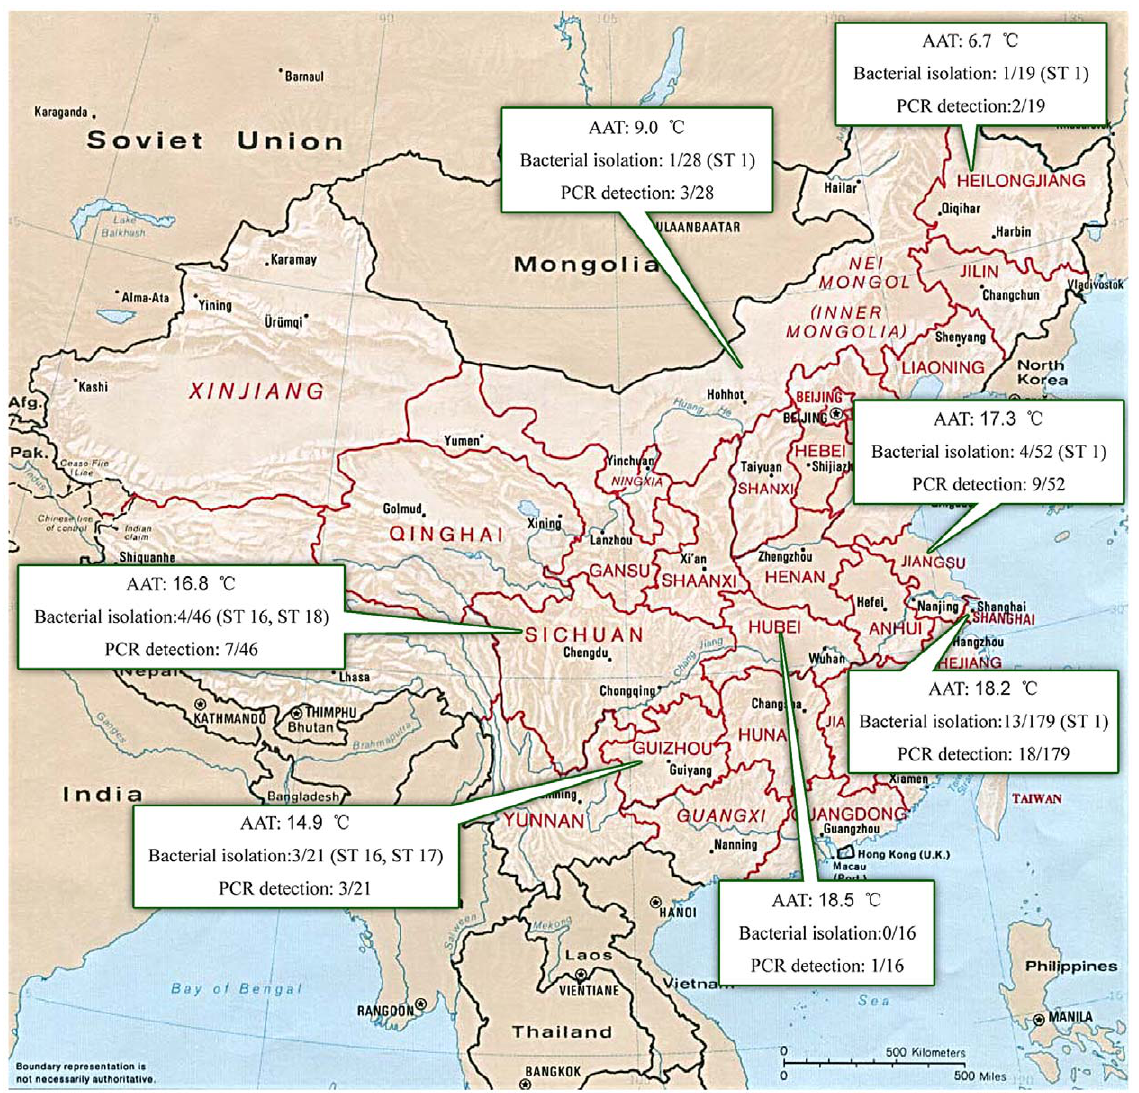
Figure 1. Geographic location of tested cats. The results of infection prevalence and the STs of isolates are specified. AAT means the average annual temperature. doi:10.1371/journal.pntd.0001301.g001 Figure 2. Infection prevalence and association with outdoor frequency, gender, age, and geographic origin. (A) The risk factors associated with B . henselae infection: ‘‘*’’ P , 0.05; ‘‘**’’ P , 0.01. (B) The results confirmed by PCR and bacterial isolation.